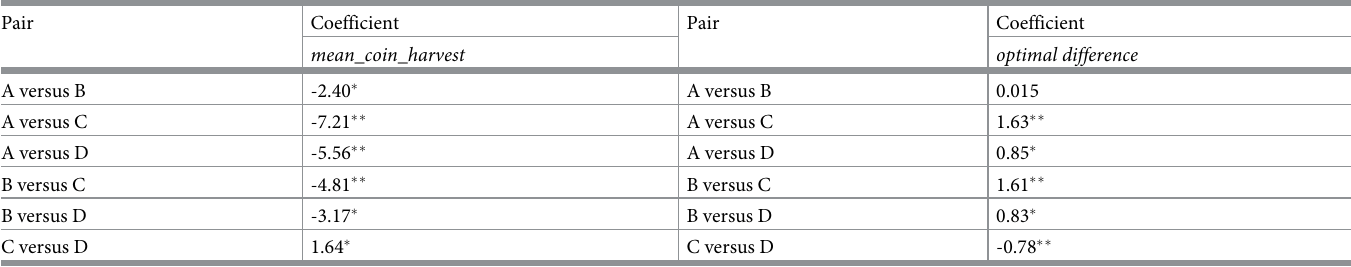
Table 3. Pair-wise tests of the treatments effect on